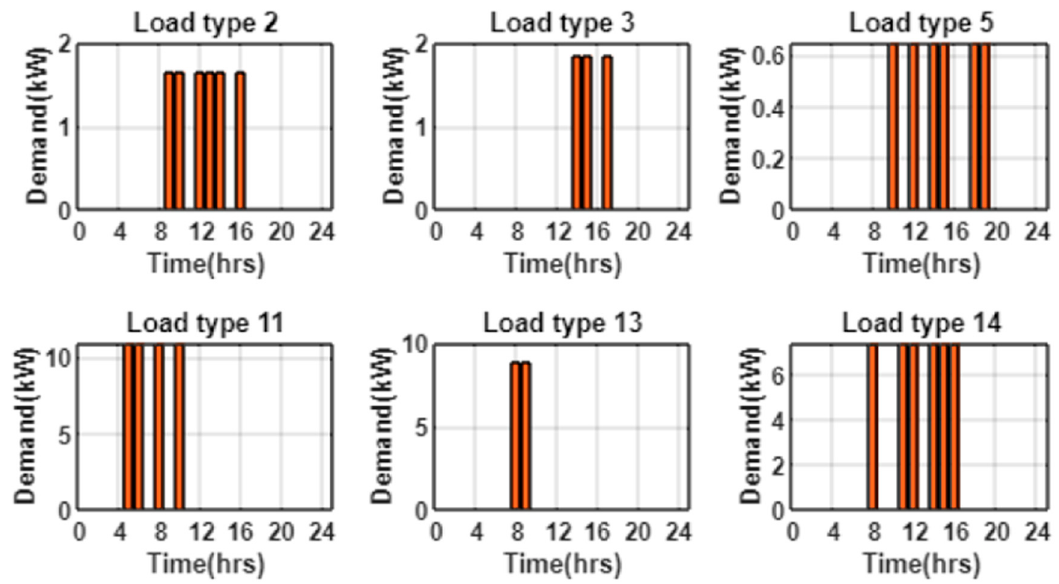
Figure 8. Scheduled operation of user comfort load after deploying the proposed EBGWO.